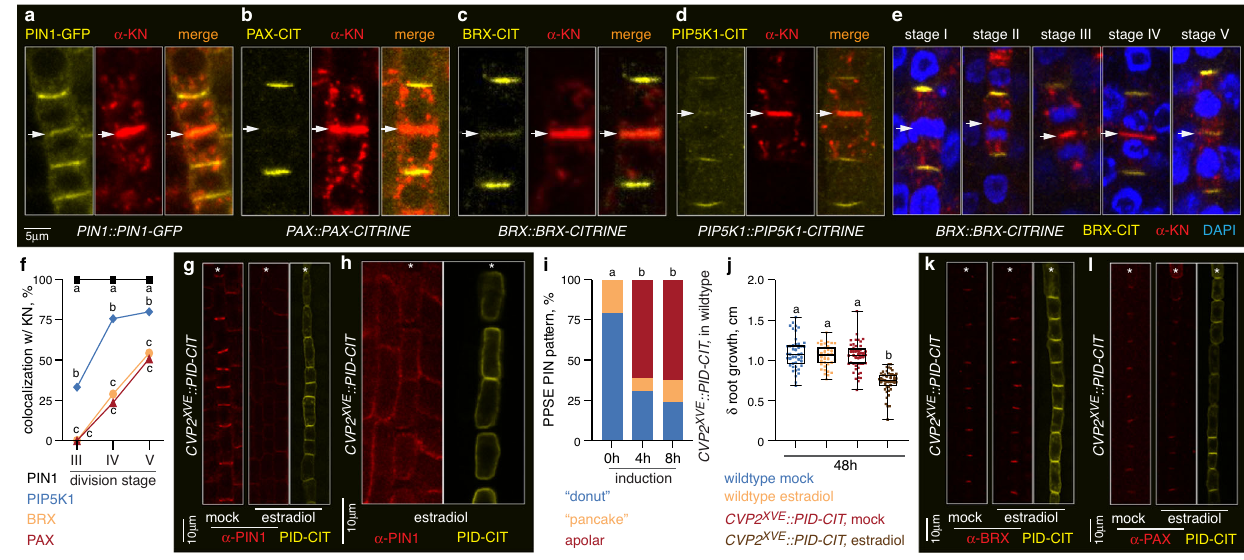
Fig. 1 | Polar auxin ef fl ux in developing protophloem sieve elements (PPSEs) is required for root development. a – d Confocal microscopy images of PIN1, PAX, BRX and PIP5K1 -GFP or -CITRINE (CIT) fusion proteins (yellow fl uorescence) expressed under their native promoters ( PIN1::PIN1-GFP ; PAX::PAX-CIT ; BRX::BRX- CIT ; PIP5K1::PIP5K1-CIT ), detected by anti-GFP immunostaining in dividing PPSEs. The (nascent) cell plates were detected by simultaneous anti-KN immunostaining (red fl uorescence). e Confocal images of BRX-CIT protein detected by anti-GFP immunostaining (yellow fl uorescence), (nascent) cell plates detected by anti-KN immunostaining (red fl uorescence), and DNAbyDAPIstaining(blue fl uorescence), in dividing PPSEs at different stages of the cell division cycle. f Quanti fi cation of PIN1, PAX, BRX and PIP5K1 colocalization with the nascent cell plate at different stages as illustrated in ( e ), representing 37 – 277 dividing cells surveyed in 44 – 332 PPSE cell fi les. Percentages indicate the fraction of cells of a given stage in which a given protein wasdetectedatthe cellplate. g Confocal images of PIN1 localization (anti-PIN1 immunostaining, red fl uorescence) in developing PPSE cell fi les (aster- isks) of 5-day-old transgenic seedlings expressing a PINOID (PID) kinase CITRINE fusion protein under control of an estradiol-inducible COTYLEDON VASCULAR PATTERN 2 promoter ( CVP2 XVE ::PID-CIT ), in mock conditions or after 8h